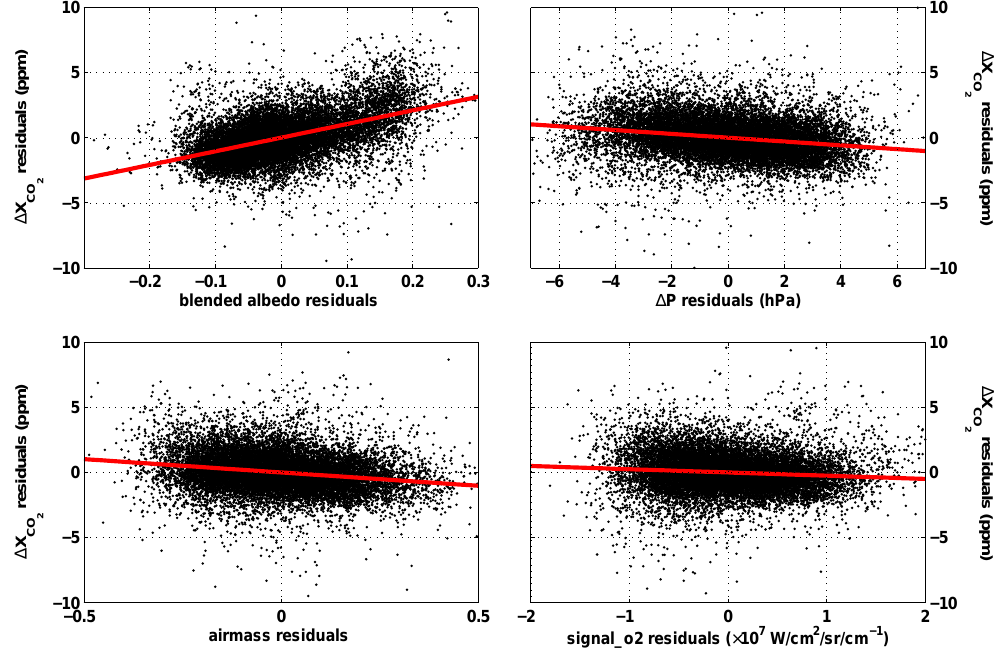
Fig. 6. Added variable plots, which show the unique influence of each of the four covariates in the multivariate linear regression of 1X CO in Eq. (4). Each plot is obtained after adjusting both 1X CO from the Southern Hemisphere, where there should be no significant X CO the coefficients listed in Table 2.